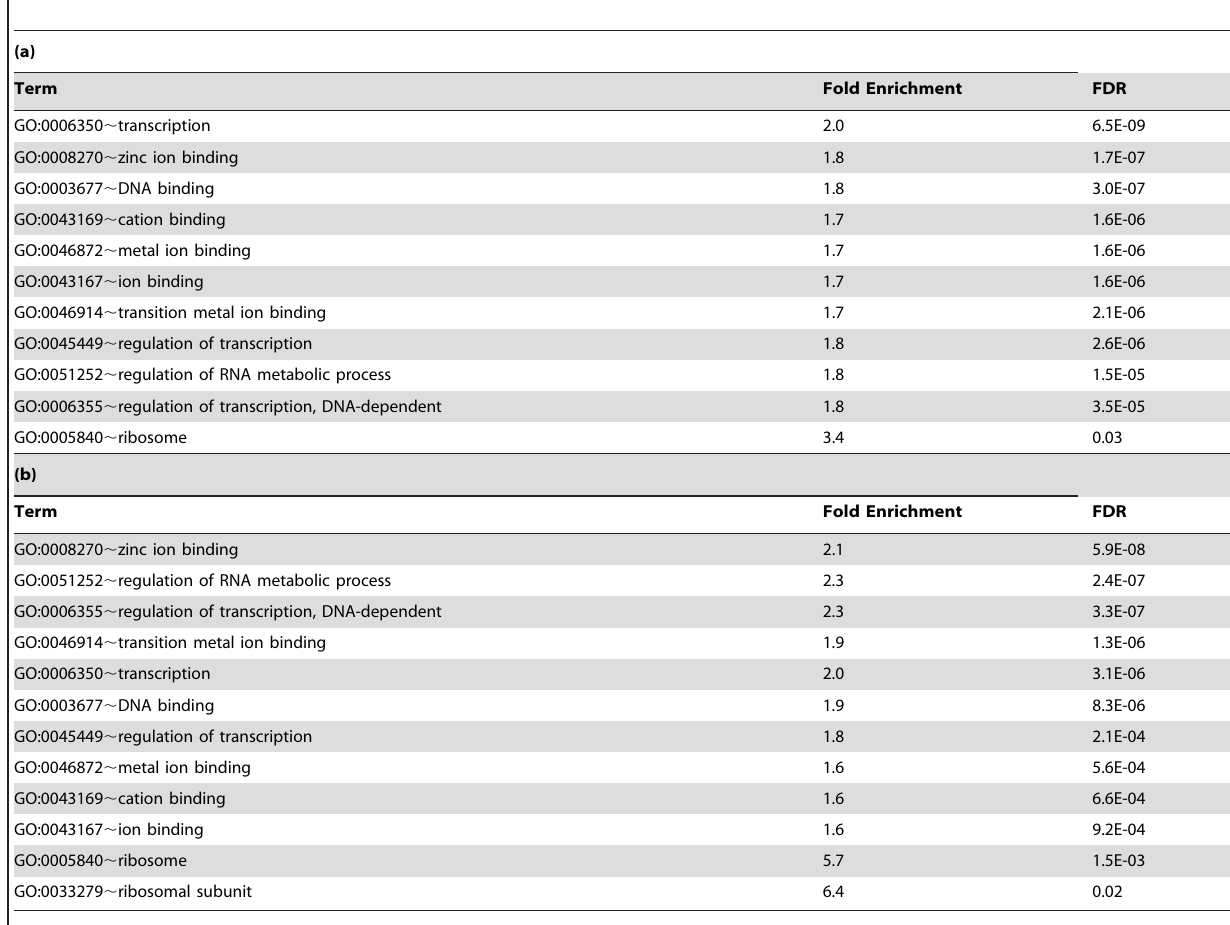
Table 1. Over-represented GO terms in fetal brain biased young genes compared to other young genes (a) and fetal brain biased old genes